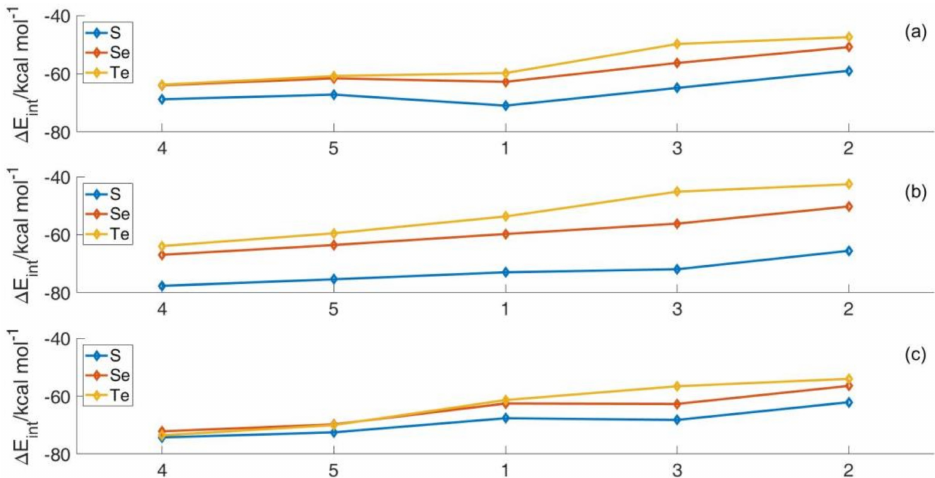
Figure 2. E int upon substituent variation. Level of theory: BLYP-QZ ( a ), M06-2X-QZ ( b ), and DLPNO-CCSD(T) ( c